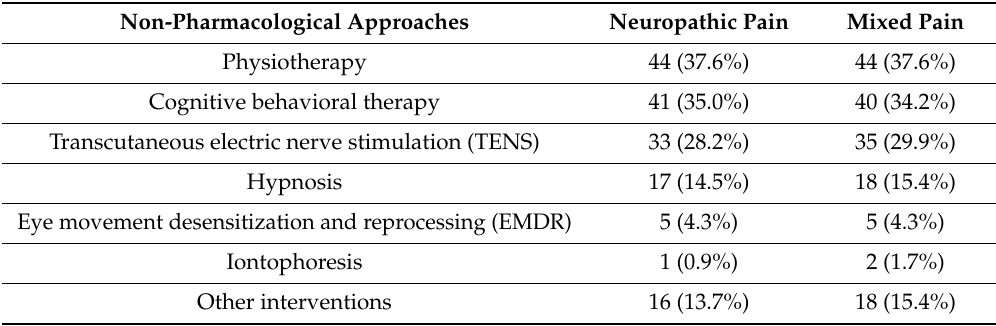
Table 9. Non-pharmacologic approaches used by practitioners in case of chronic neuropathic or mixed pain in